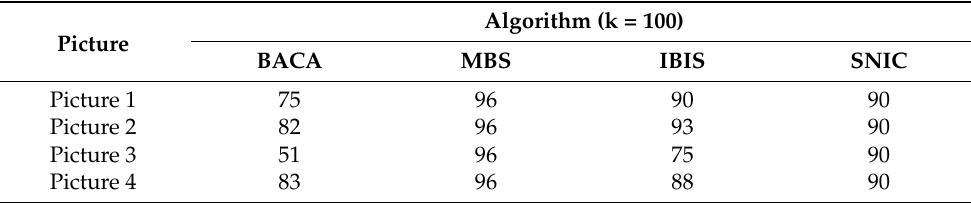
Table 2. Actual superpixels number of different algorithms on different pictures (k = 100).